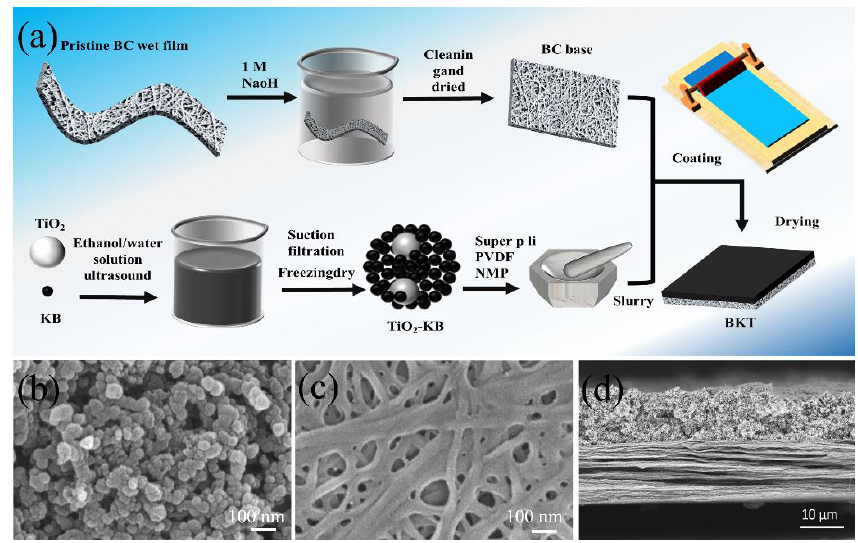
Figure 1. ( a ) Schematic diagram of the preparation process of BKT separator; ( b , c ) SEM images of the coated surface and non-coated surface of the BKT separator, respectively; ( d ) Cross section SEM of BKT separator.